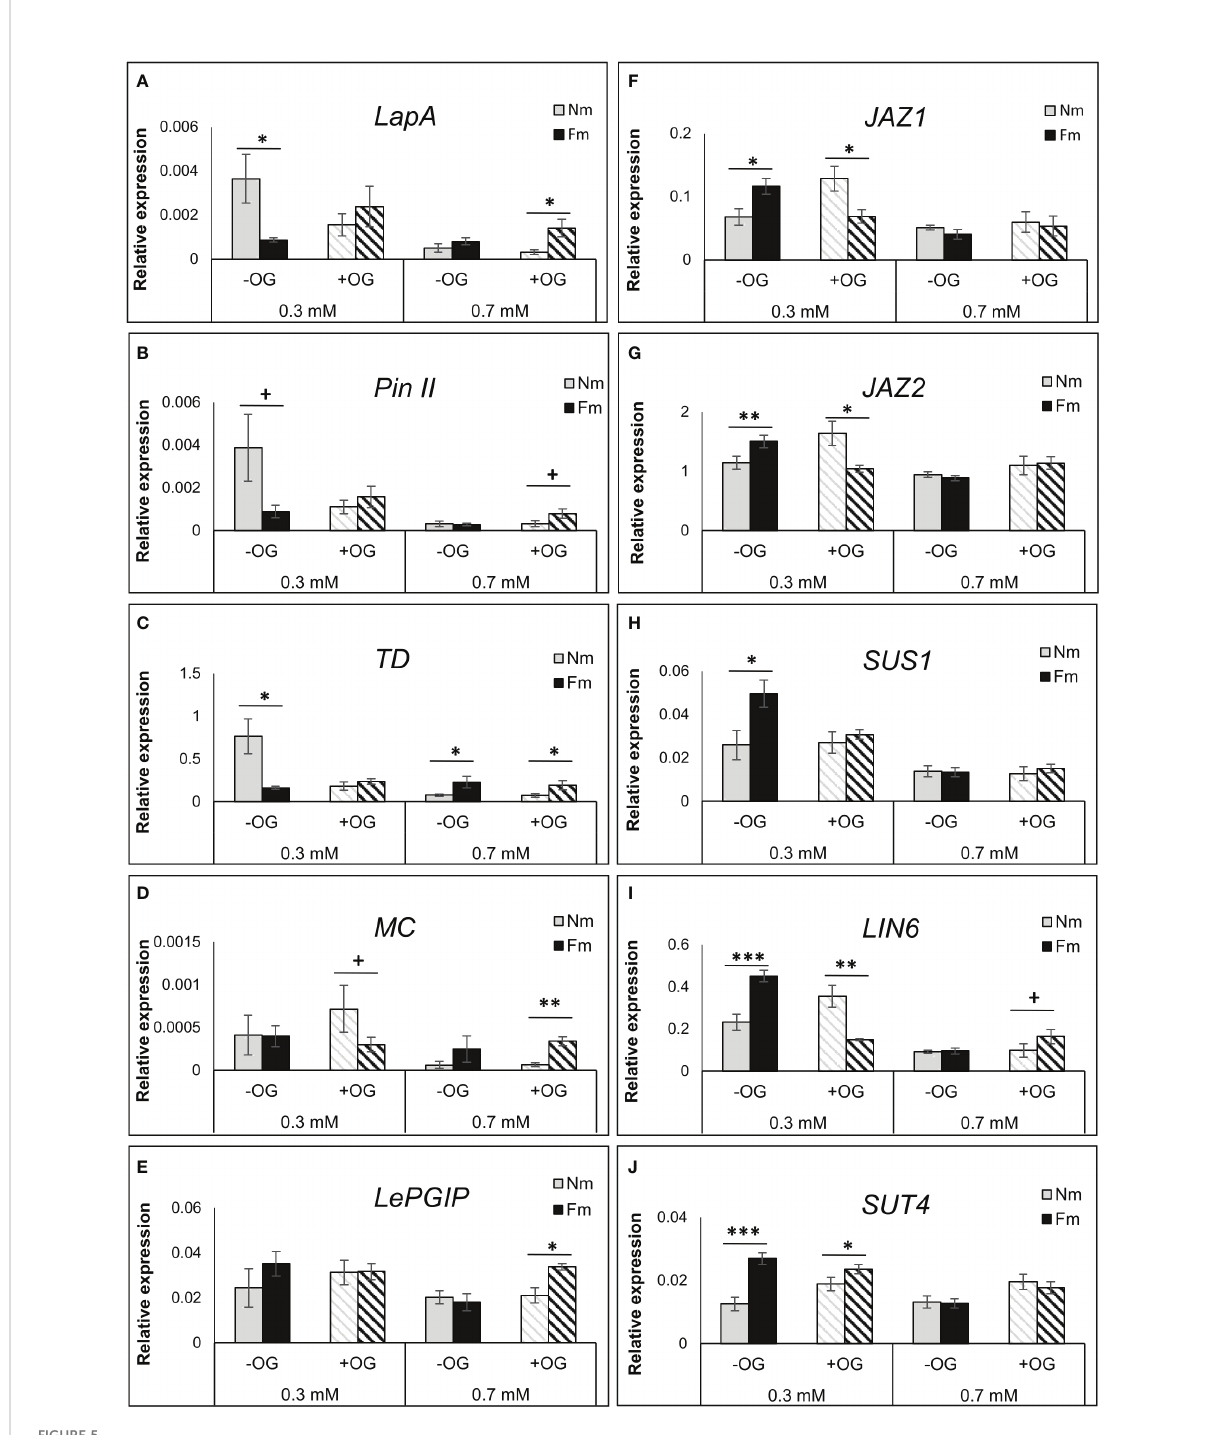
FIGURE 5 Transcriptional regulation of defense- and growth-related genes. Gene expression levels in OG-treated (+OG; stripped bars) or water-treated (-OG; fi lled bars) leaves of non-mycorrhizal (Nm) and mycorrhizal (Fm) plants grown under 0.3 mM and 0.7 mM P fertilization regimes. Realtime quantitative RT-qPCR analysis of genes coding for the (A) leucyl aminopeptidase A (LapA), (B) proteinase inhibitor II (PinII), (C) threonine deaminase (TD), (D) multicystatin (MC), (E) polygalacturonase inhibiting protein (LePGIP), (F) JASMONATE ZIM DOMAIN 1 (JAZ1), (G) JASMONATE ZIM DOMAIN 2 (JAZ2), (H) sucrose synthase-1 (SUS1), (I) cell wall invertase 6 (LIN6) and (J) sucrose transporter 4 (SUT4) are shown.Values were normalized to the tomato housekeeping gene b-tubulin. Bars represent mean ± SD from 6 biological replicates. Asterisks indicate signi fi cant differences between Nm and Fm within the same treatment according to t-test. +: p<0.1; *: p<0.05; **: p<0.01; ***: